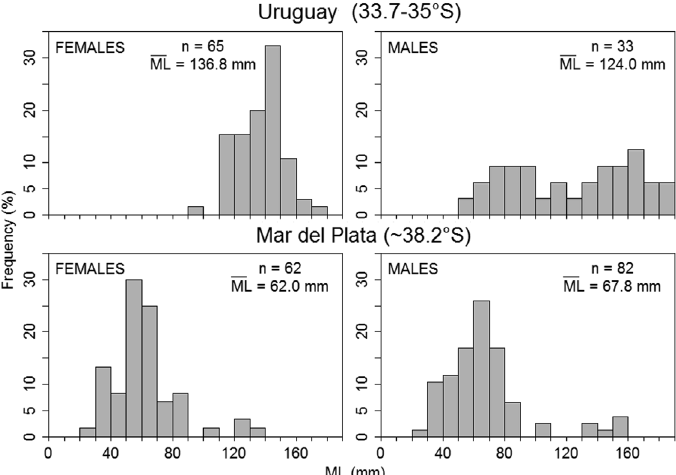
Figure 8. Size structure of Doryteuthis sanpaulensis according to the subareas nested within the Uruguayan-Argentinean coast (33.7–38.2°S). spermatophores in the buccal receptacle occurred more fre- quently in mature females (n = 19), followed by spent (n = 6) and maturing squids (n =